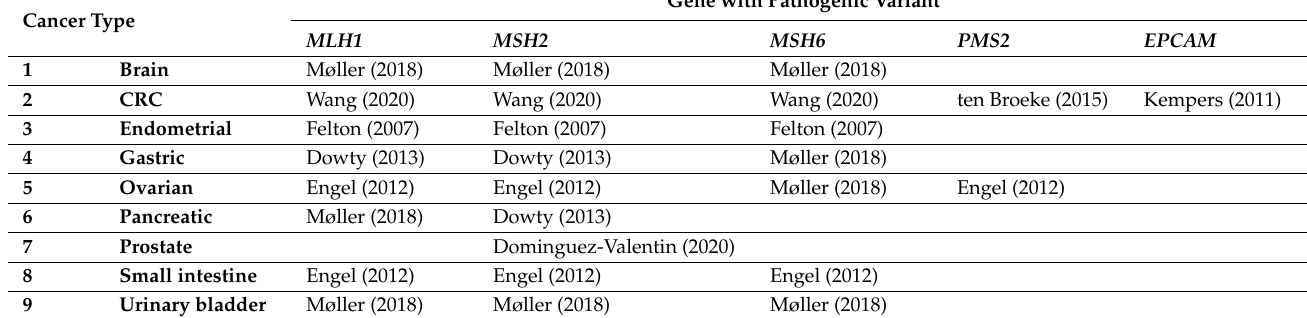
Table 2. References used to estimate the baseline ACPs for each gene-cancer association. Blank cells indicate that no association between a gene and cancer was incorporated into MyLynch due to a lack of sources that could demonstrate individuals with a PV in the corresponding gene were at significantly higher risk for the corresponding cancer than someone without a PV in that gene. Refer to the following references for the sources in this table: Dominguez-Valentin (2020) [1], Dowty (2013) [28], Engel (2012) [42], Felton (2007) [33], Kempers (2011) [4], Møller (2018) [43], ten Broeke (2015)